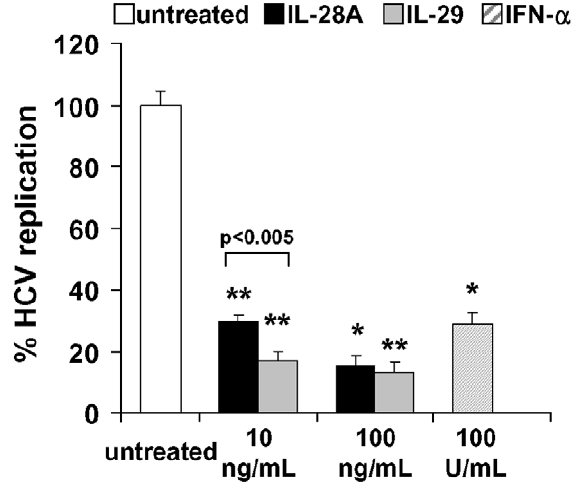
Figure 4. IL-28A and IL-29 significantly decrease HCV replica- tion. In luciferase assays with HCV replicon expressing cells, 10 or 100 ng/mL IL-28A or IL-29 strongly reduced HCV replication up to 84.8% and 87.7%, respectively, compared to untreated cells (p , 5 6 10 2 14 ; IFN- a : 72.5% reduction vs. untreated, p , 5 6 10 2 13 ).